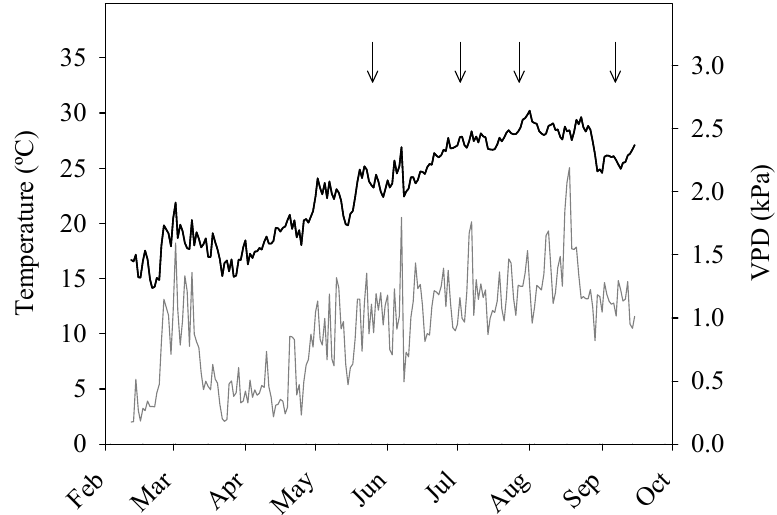
Figure 2. Daily average temperature (black line) and vapor pressure deficit (VPD) (gray line) during the experiment. The arrows indicate the days on which physiological parameters were measured. Soil sensors were fully inserted vertically in the east-facing quadrant of the root ball, between two emitters. Three probes per treatment were installed in random pots, with one sensor per pot. The volumetric water content (VWC) was calculated from the voltage output of the EC5 sensors (mV) using a substrate-specific calibration equation. The calibration line was obtained following the procedure described by Vald é s et al. [33]: VWC = 4.942 mV − 0.676, R 2 = 0.98. The CR1000 data-logger was programmed using Loggernet 3 (Campbell Scientific Inc.) to log the sensor output every 1 h during the experiment. The outputs were immediately converted to VWC by the CR1000 using the calibration equation. An example of the evolution of substrate moisture over time is given in Figure 3.